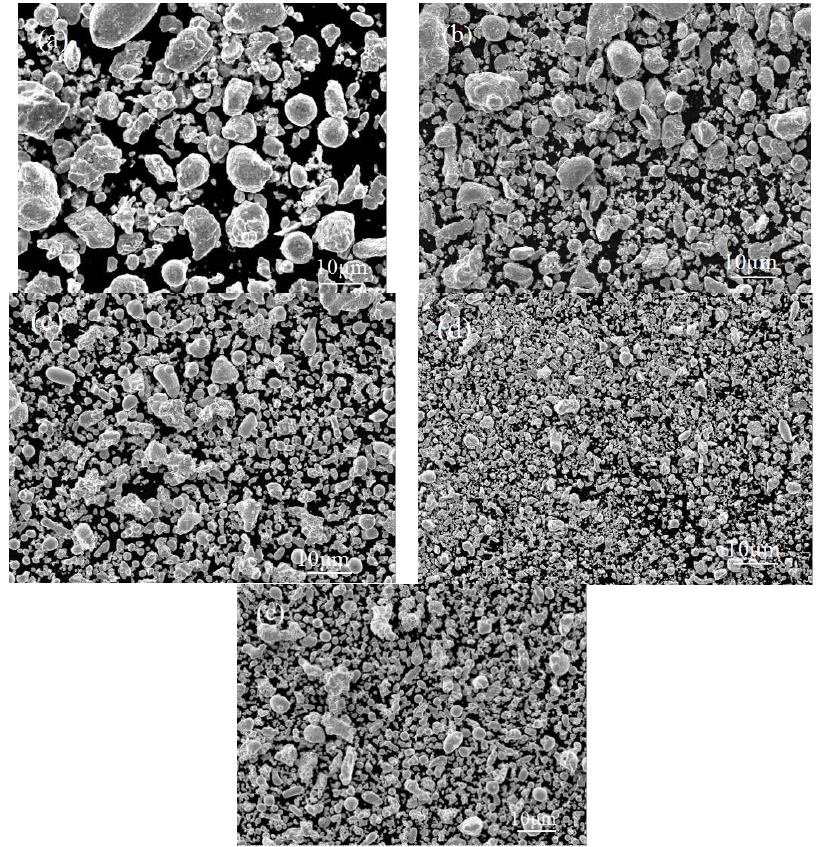
Figure 3. Scanning electron microscope (SEM) photographs of Cu-based alloy powders milled for 5 h ( a ), 10 h ( b ), 15 h ( c ), 20 h ( d ) and 25 h ( e ).